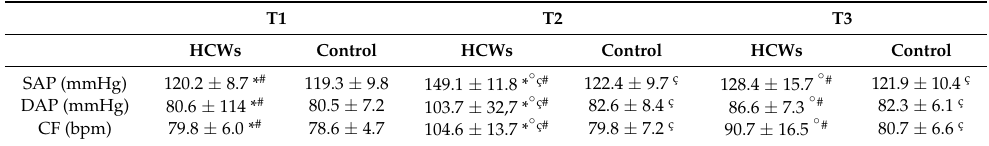
Table 2. Mean values of SAP, DAP and CF in COVID-19 OU HCWs and in the control group, detected during 8 recording hours (T1–T3).